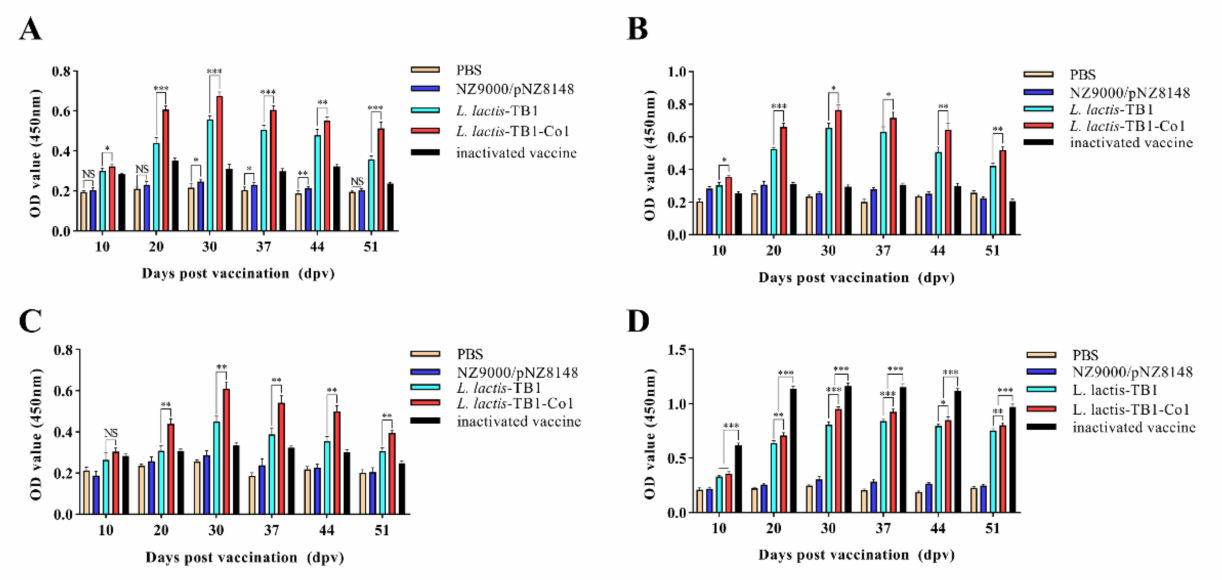
Figure 2. Levels of FMDV-specific antibodies in mice. ( A ) IgA levels in serum on days 10, 20, 30, 37, 44 and 51. ( B ) SIgA antibody levels in intestinal fluid on days 10, 20, 30, 37, 44 and 51. ( C ) SIgA antibody levels in lung lavage fluid on days 10, 20, 30, 37, 44 and 51. ( D ) IgG antibody levels in serum on days 10, 20, 30, 37, 44 and 51. Data are shown as mean ± SD. Analyses were carried out by multiple t tests (NS = p > 0.05; * p < 0.05; ** p < 0.01; *** p < 0.001). Ig, immunoglobulin; SD, standard